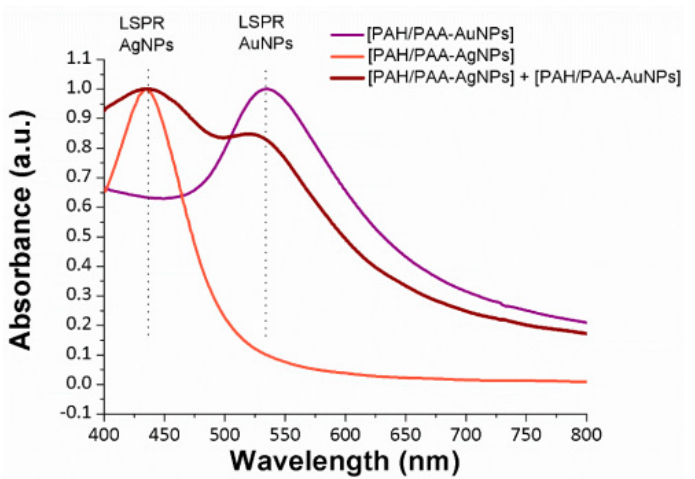
Figure 10. UV-Vis spectra of the LbL films for [PAH/PAA-AuNPs] (violet line), [PAH/PAA-AgNPs] (orange line) and [PAH/PAA-AgNPs] + [PAH/PAA-AuNPs] (red line), respectively. Reprinted with permission of [50].